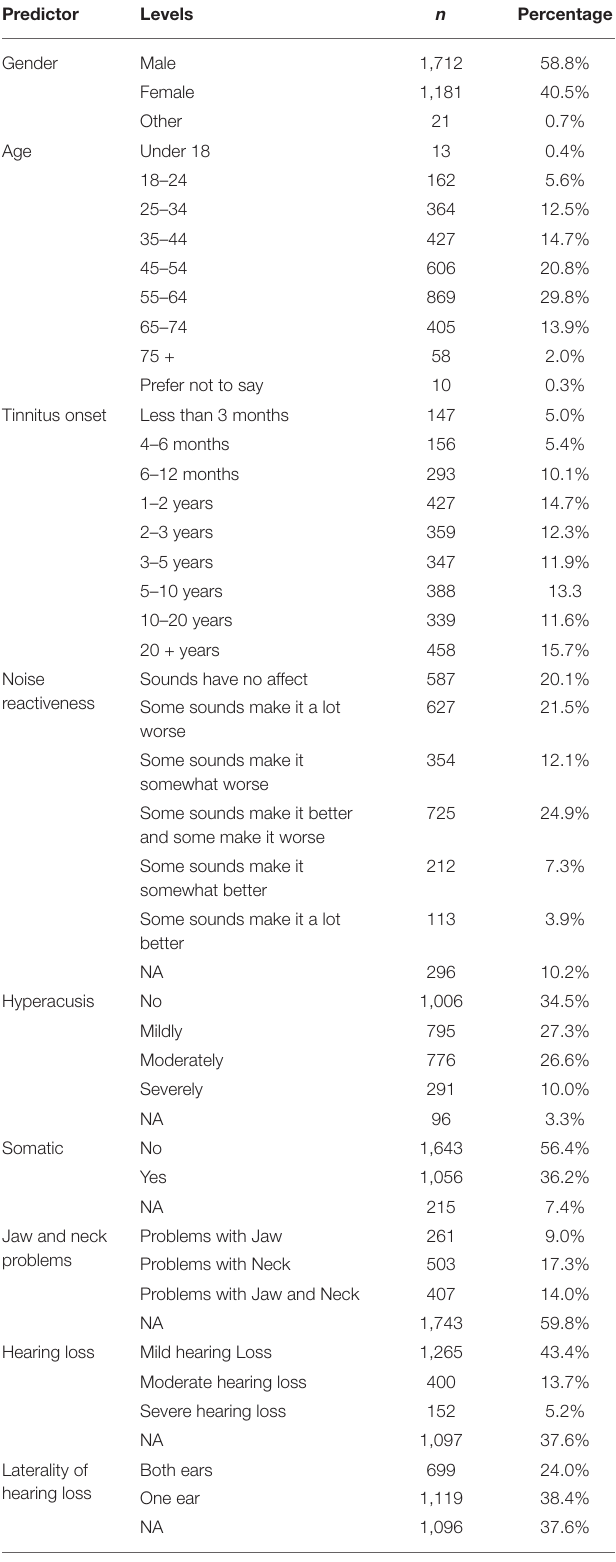
TABLE 2 | Sample’s demographic and tinnitus